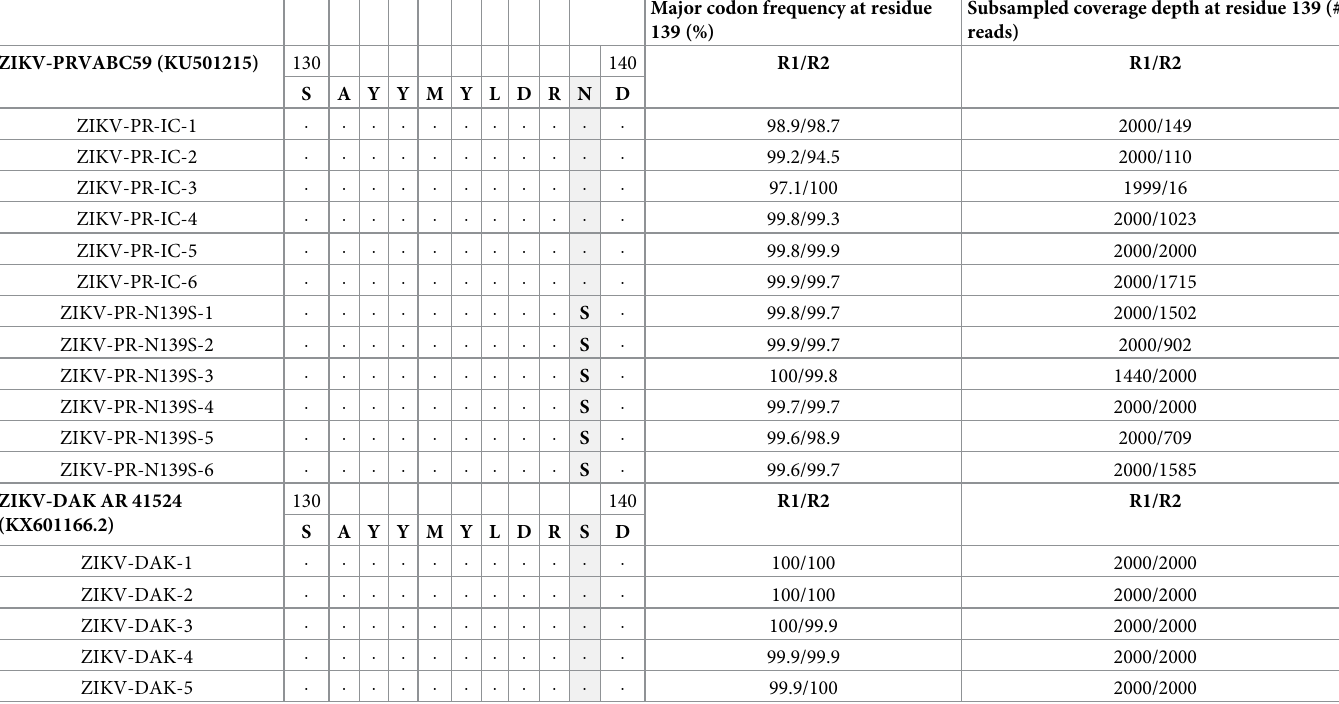
Table 1. Deep sequencing of virus populations replicating in maternal serum. Serum samples from pregnant mice infected with ZIKV-PR-IC, ZIKV-PR-N139S, and ZIKV-DAK were deep sequenced in duplicate (R1, R2) and analyzed with the “Zequencer 2017” workflow to confirm the expected residue at position 139. The major codon found at residue 139 for each sample is indicated by gray